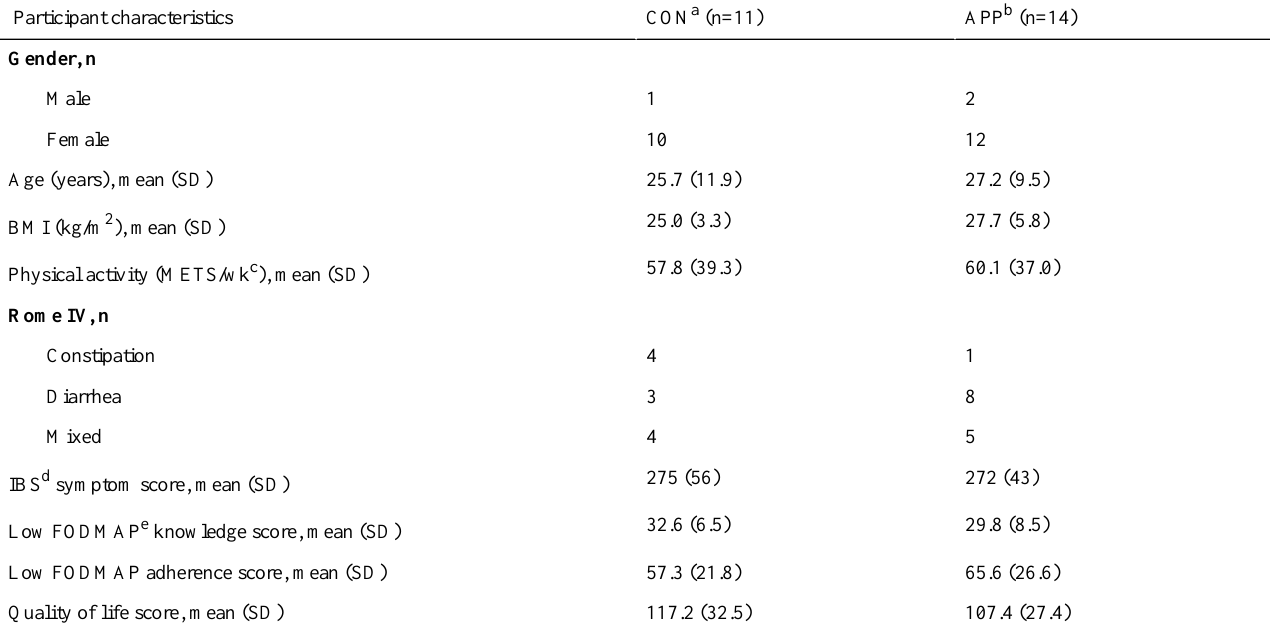
Table 1. Baseline characteristics.